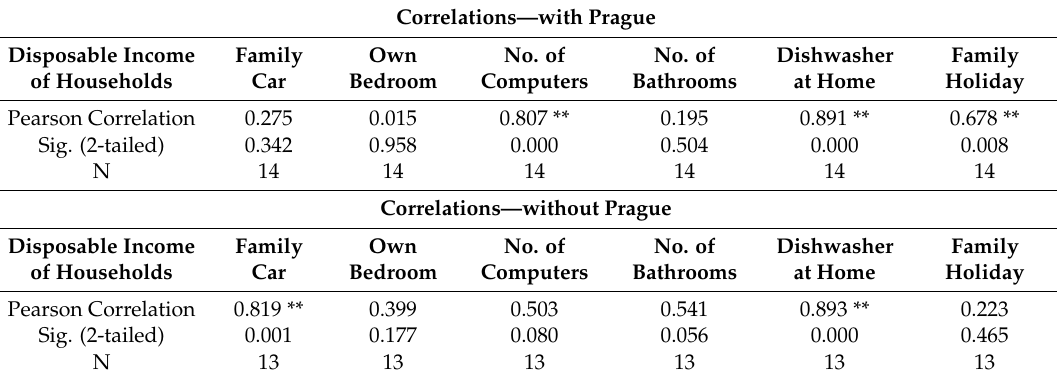
Table 5. Correlation coefficients and significances per questionnaire item including/excluding Prague.